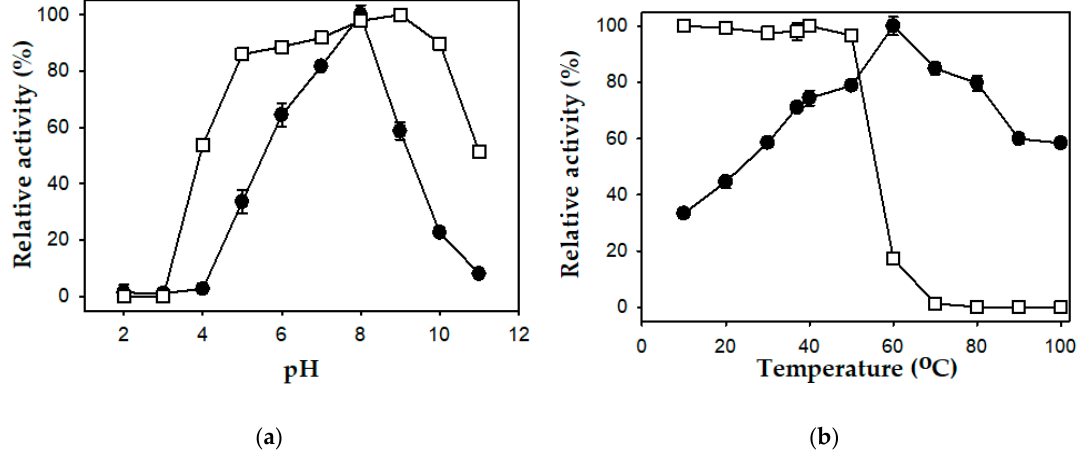
Figure 4. E ff ects of pH ( a ) and temperature ( b ) on the activity ( • ) and stability ( (cid:3) ) of the P. mucilaginosus Figure 4. Effects of pH ( a ) and temperature ( b ) on the activity ( ● ) and stability ( □ ) of the P. TKU032 protease. The error bar is the standard deviation of three mucilaginosus TKU032 protease. The error bar is the standard deviation of three repetitions.